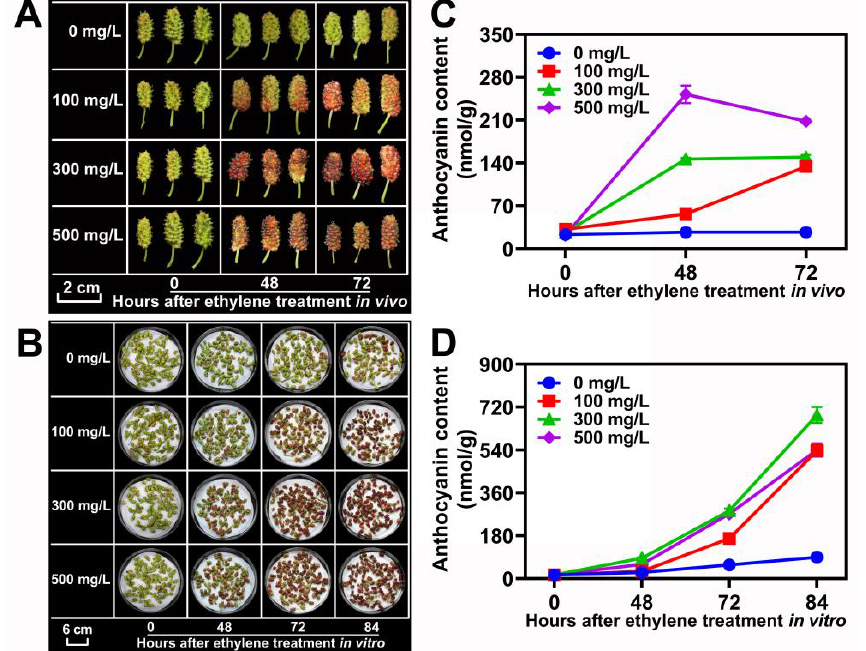
Figure 7. Ethylene increased the coloration and anthocyanin accumulation in ZJ fruits. ( A , B ) Mor- phology of ZJ fruits treated by specific concentrations of ethylene (0 – 500 mg/L) at different times in vitro and in vivo. ( C , D ) Anthocyanin content in ZJ fruits that were administered different concen- trations of ethylene in vivo and in vitro. Data are mean± standard error, with three biological repli- cates.